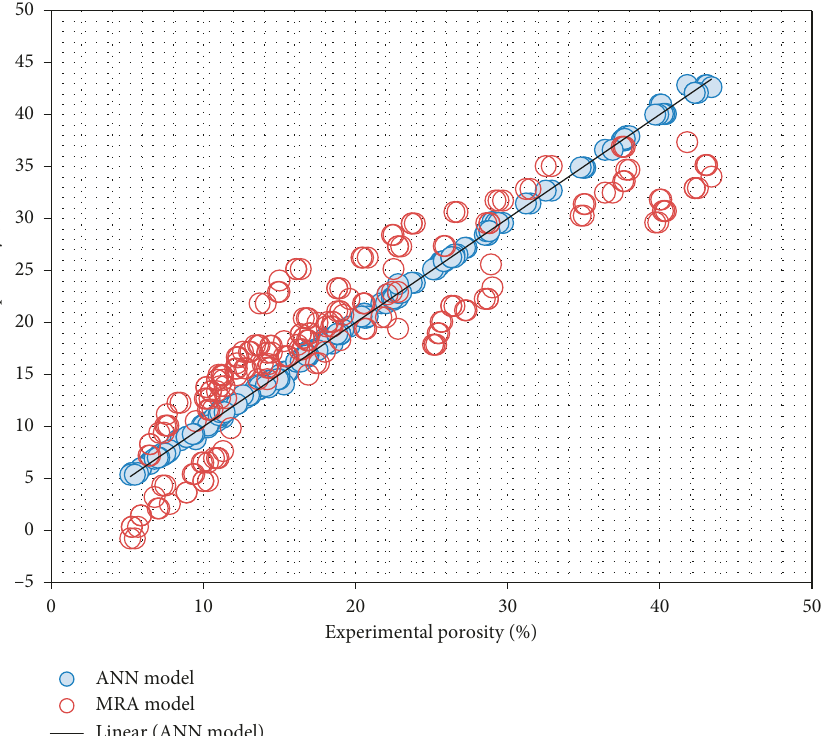
Figure 17: Predicted concrete porosity versus experimental concrete porosity for models ANN1 and